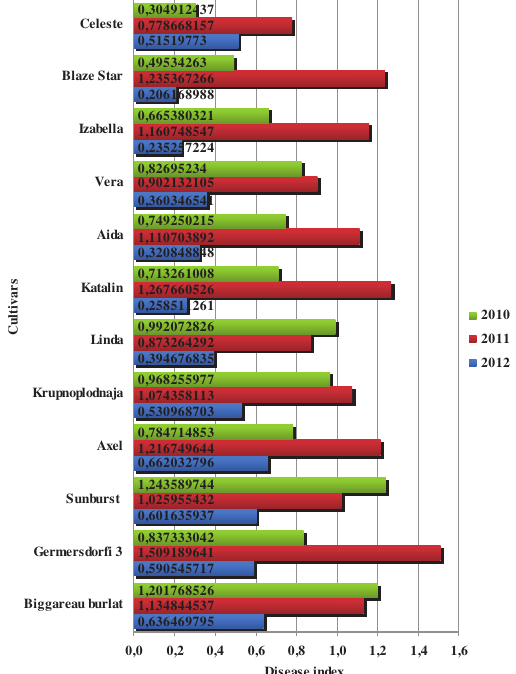
Figure 2: Disease index (0-5) of cherry leaf spot incidence for 12 sweet cherry cultivars (Debrecen-Pallag,